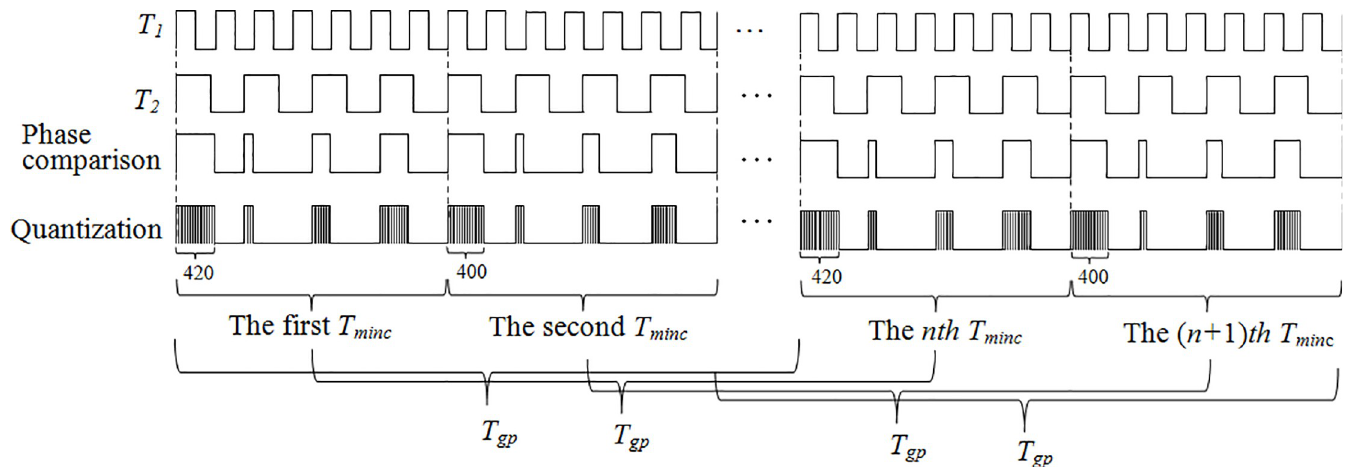
Fig 1. Group quantization phase